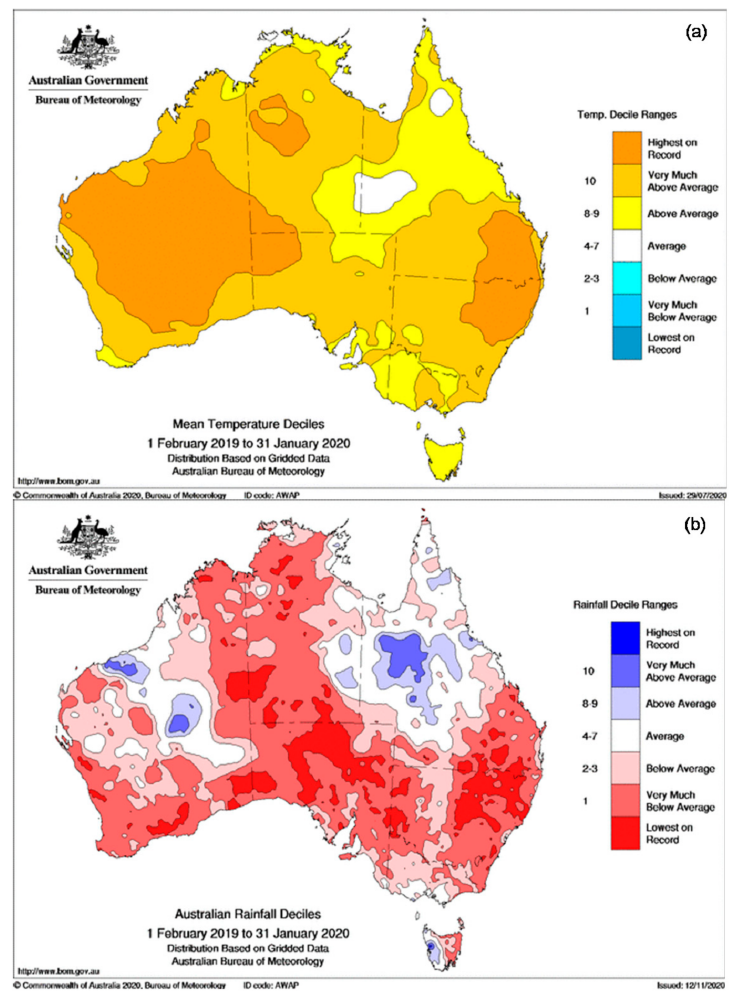
Figure 1. Climate change effect on ( a ) mean temperature and ( b ) rainfall in Australia based on all years of data since 1910 ([10], reproduced under the Creative Commons Attribution Australia Licence https://creativecommons.org/licenses/by/3.0/au/legalcode). It should be noted that the average temperature and rainfall benchmarks are based on data collected from 1910. It can be observed that for the 12-month period shown in Figure 1, a great percentage of their territories recorded the highest on record mean temperature with greater prevalence in the Western Australia state. Except for the state of